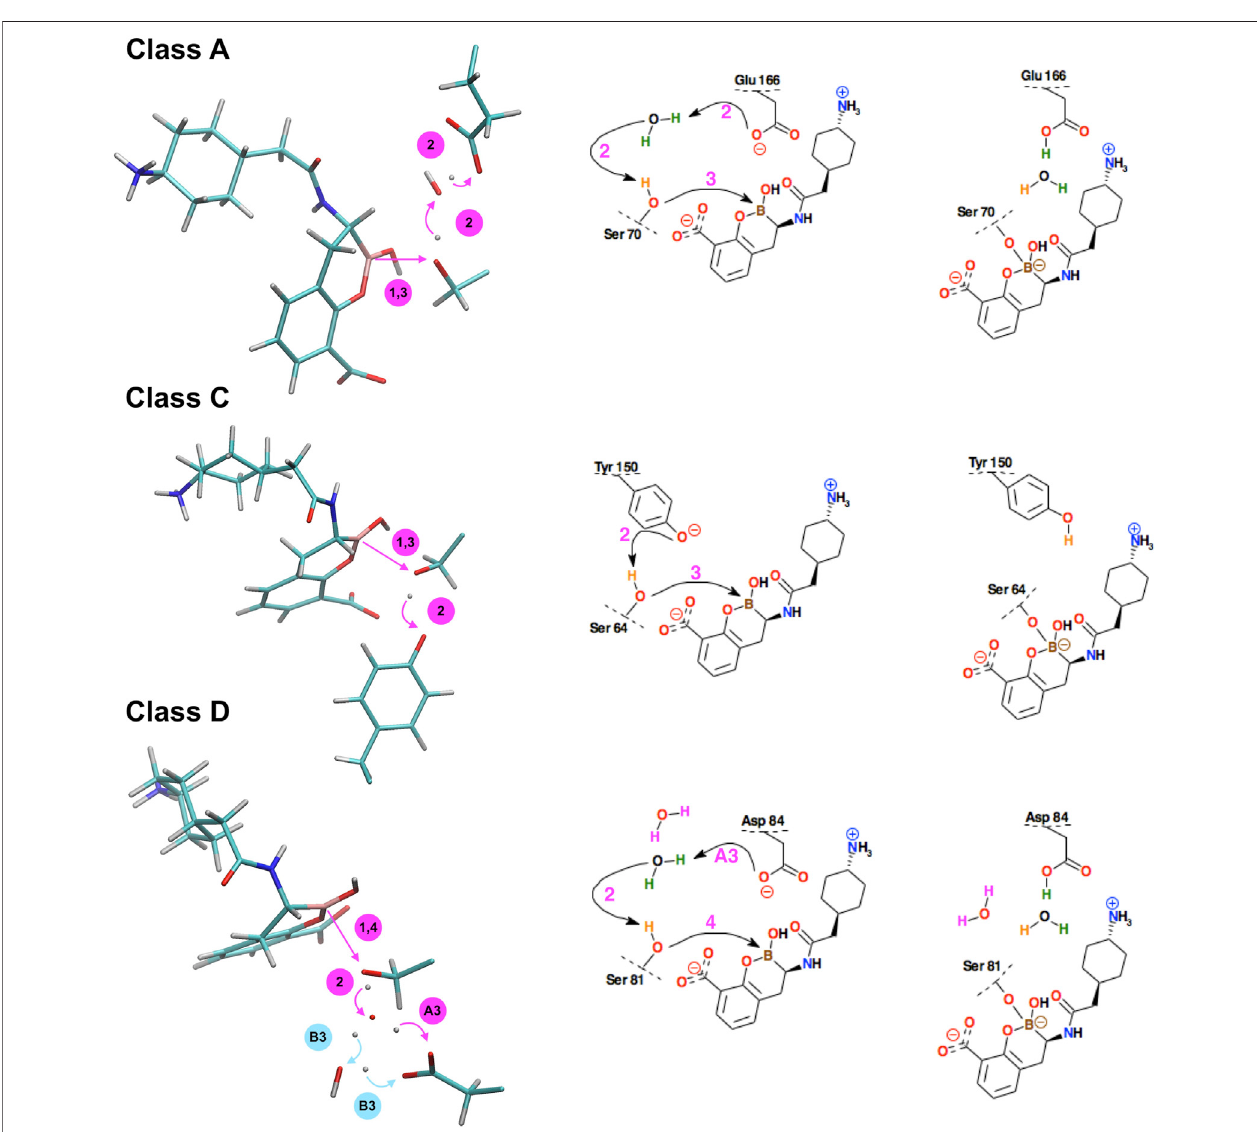
FIGURE7| Schematicrepresentationofthesuccessivestepsintheformationofthechemicalbondbetweentheboronatomofbicyclicboronateinhibitor(BBI)and thehydroxylgroupsofserine β -lactamases.TheactivesiteresiduesbelongtoKPC-2 β -lactamase(classA),GC1 β -lactamase(classC),andtheK84DmutantofOXA-24 β -lactamase (class D). Curved arrows indicate the proton transfer processes, straight arrows indicate distance reduction. In class D, steps #A3 and #B3 denote two distinct reaction paths leading to different protonation of Asp84 in the fi nal structure. On the right, conventional simpli fi ed diagrams showing reaction steps - the arrows symbolically indicate the electron transfer processes. Description of the time-periods related to the presented steps is given in Table 2 .